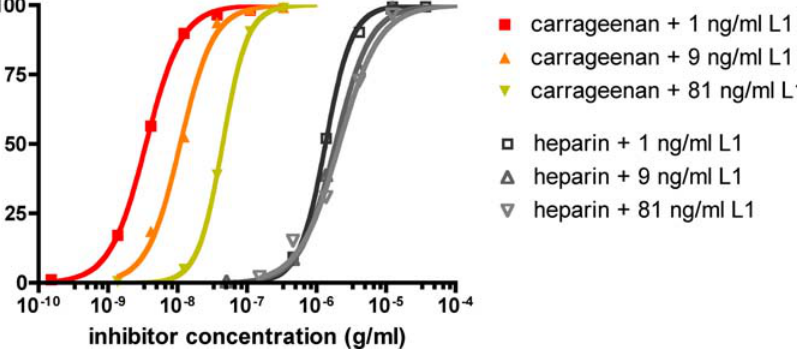
Figure 2. Capsid Dose Influences Carrageenan IC 50 Inhibition assays were performed using a standard dose of GFP-expressing HPV16 PsV in the presence of increasing doses of cold capsids. Overall capsid dose is given as the final concentration of the major capsid protein, L1, in the culture